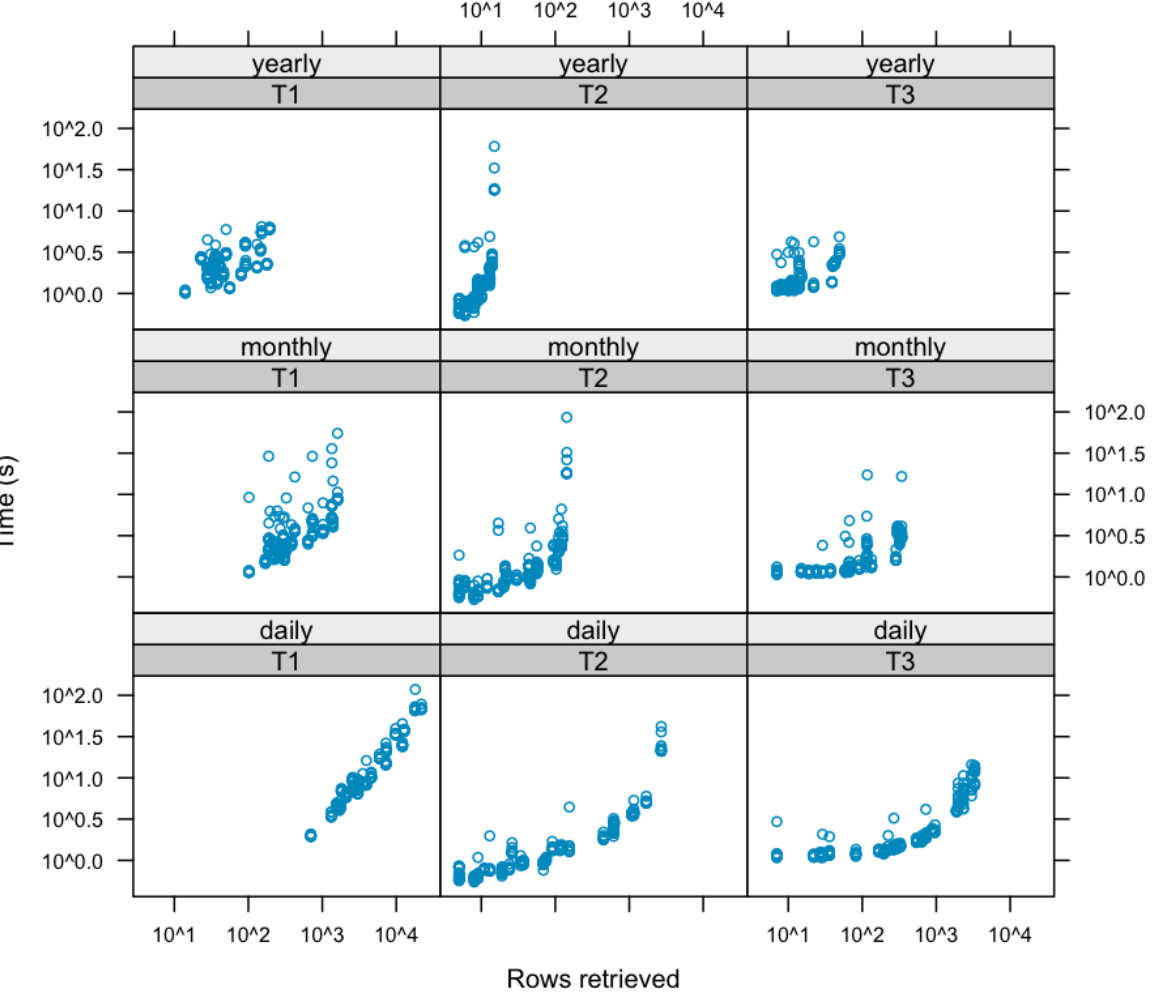
Figure 6. Query performance. Response time and rows retrieved by template (1-3) and aggregation period. As the number of rows retrieved increases, the response time tends also to